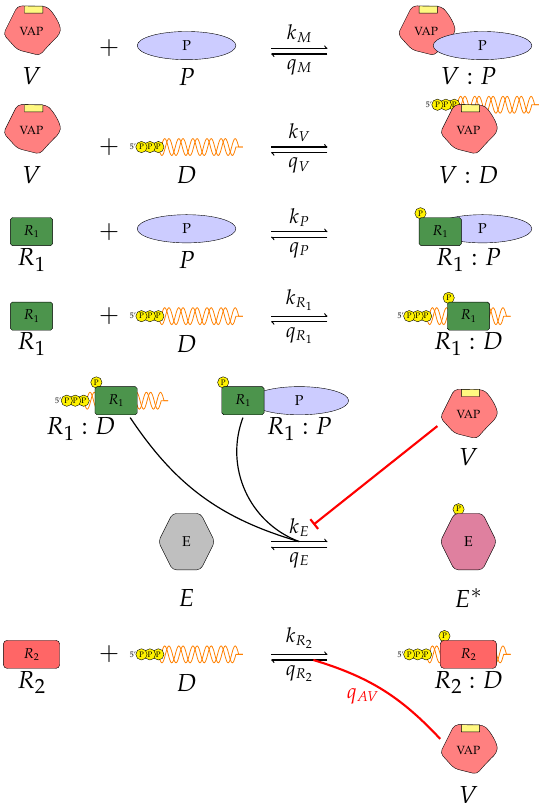
Figure 12. A general model of viral type I IFN inhibition. The model includes: V , the viral antagonistic protein for the virus under consideration; D , the viral RNA; R 1 , a PRR; P , a dsRNA binding protein; R 2 , an RNA-activated kinase; and E , a downstream enzyme kinase. The model includes two potential signalling pathways that result in stimulation of type I IFN